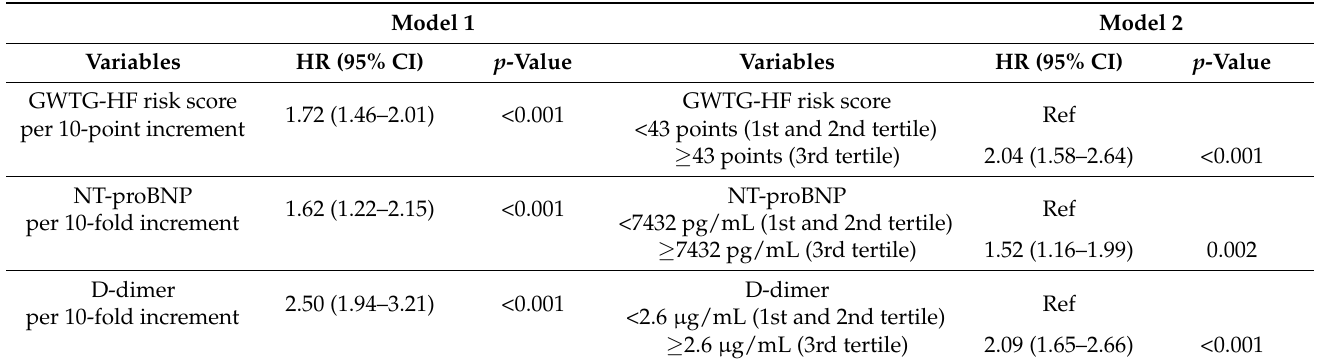
Table 4. Multivariate predictors of cardiovascular mortality in all study